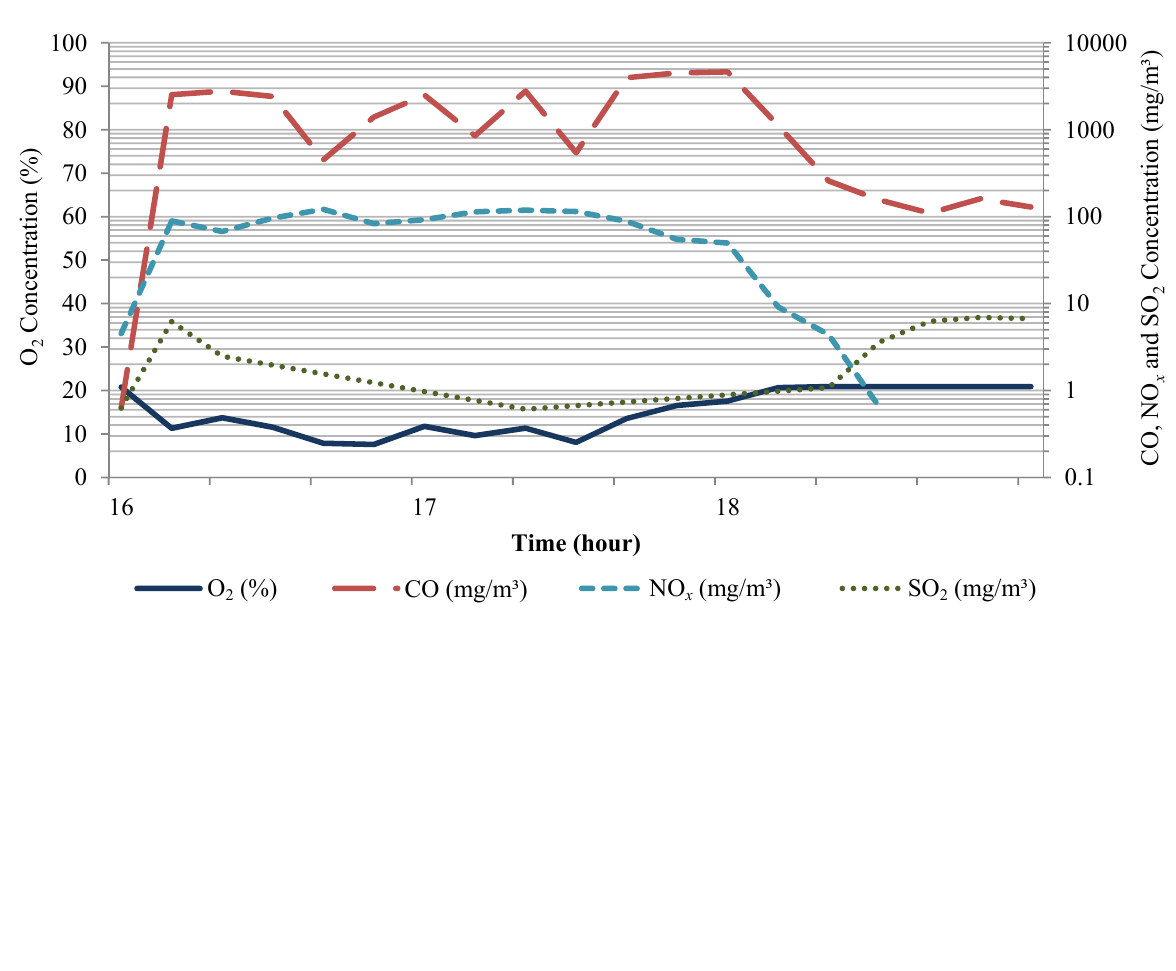
Figure 3. Typical flue gas emission concentrations for WS (bale S1